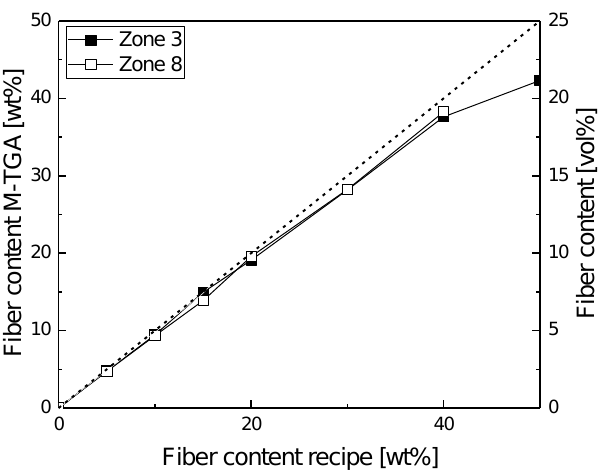
Figure 2. Comparison of the fiber content determined with the M-TGA on universal test specimen vs. the nominal fiber content of the recipes for two different dosing positions (zone 3 and 8) in compounding (fiber content in vol% is shown on the secondary y -axis as an orientation, as the following properties are presented in correlation with it instead of wt%).